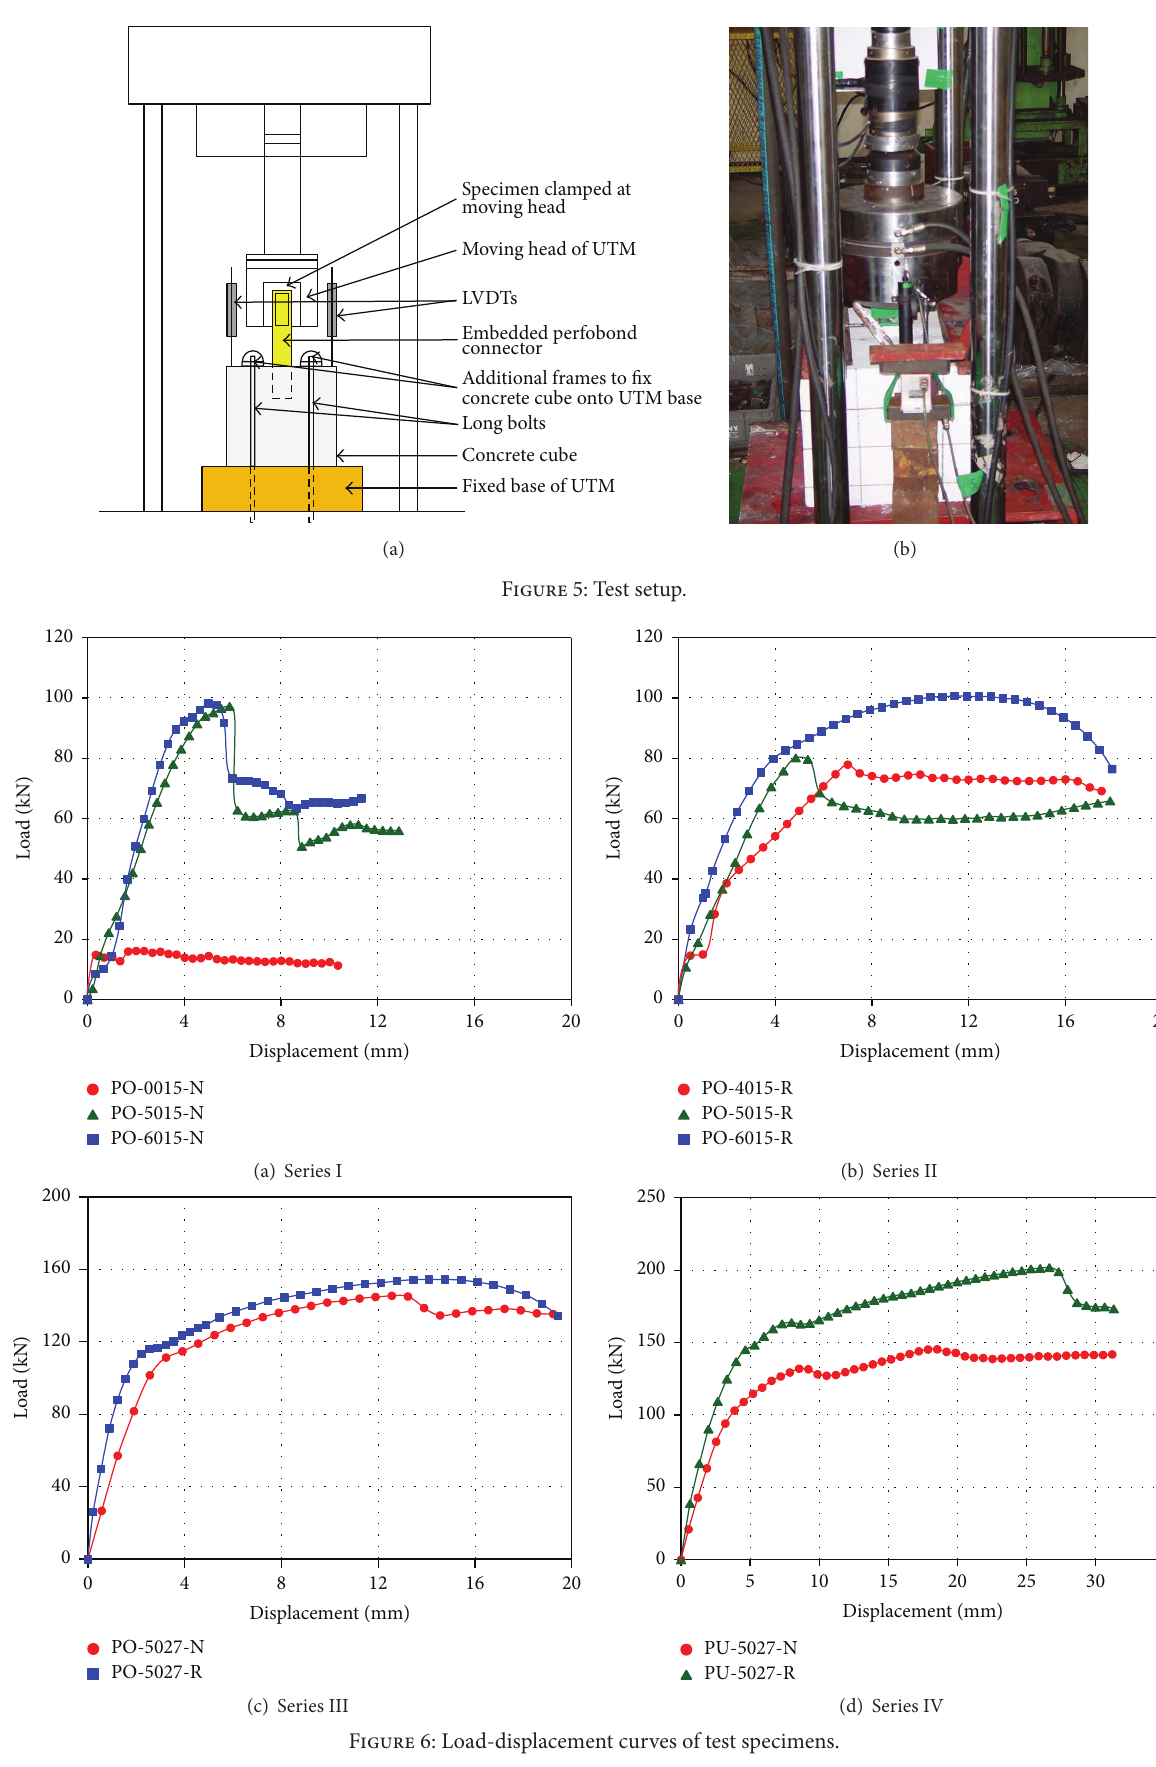
Figure 6: Load-displacement curves of test